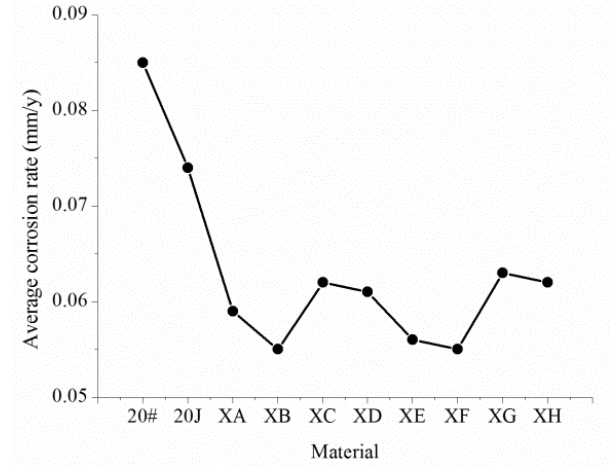
Figure 6. Average corrosion rate of different materials.